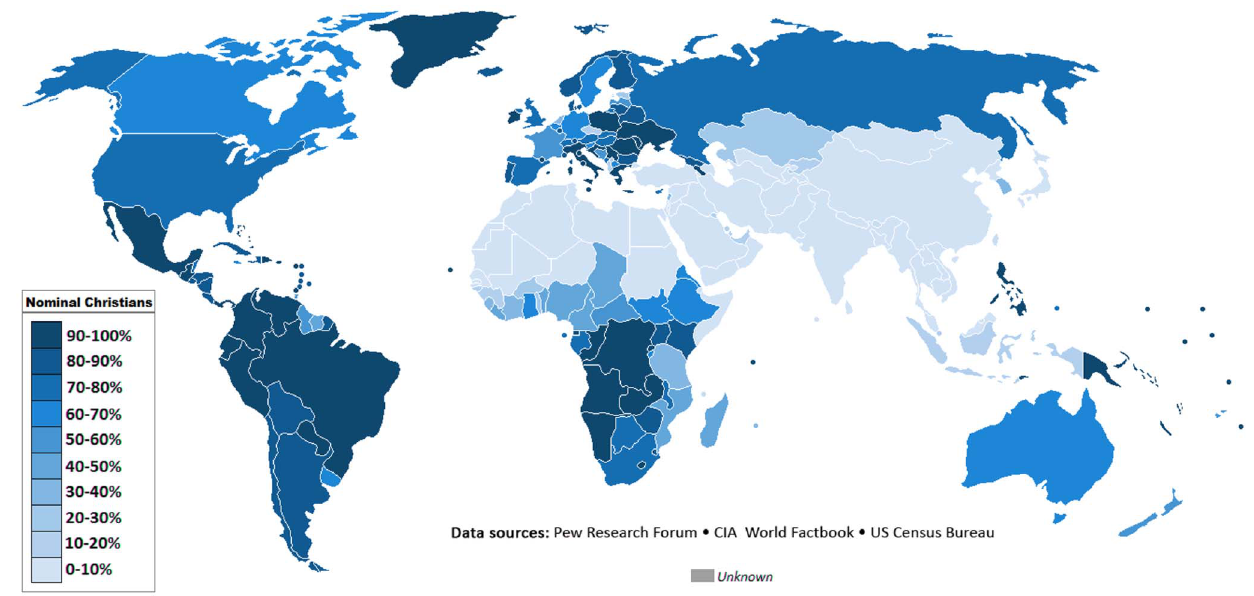
Figure 1. Christianity—percentage by country (2010). http://en.wikipedia.org/wiki/File:Christian_distribution.png.